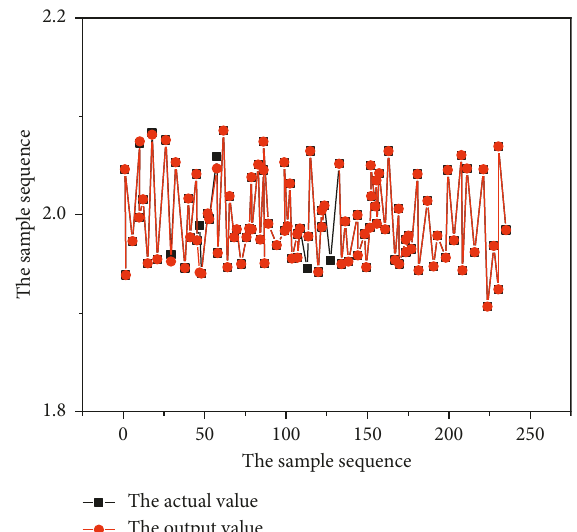
Figure 6: Training results of dissolved oxygen mass concentration soft sensing model.